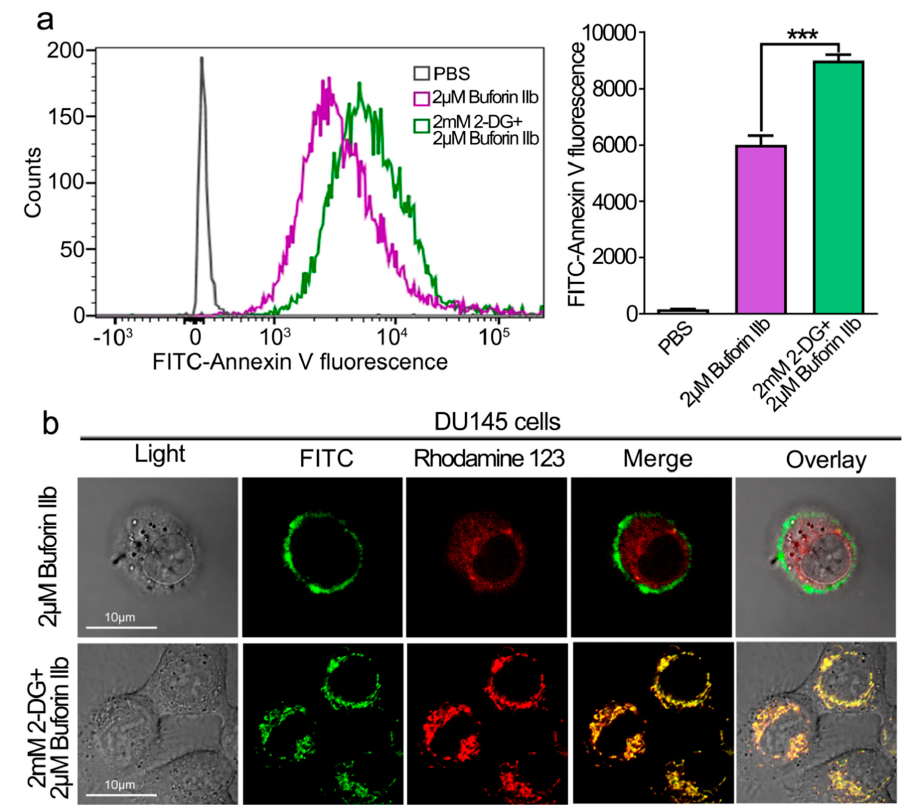
Figure 4. E ff ect of 2-DG on cellular entry and mitochondrial binding of FITC -buforin IIb in DU145 cells. ( a ) DU145 cells pretreated with or without 2-DG for 24 h were incubated with FITC-buforin IIb for 2